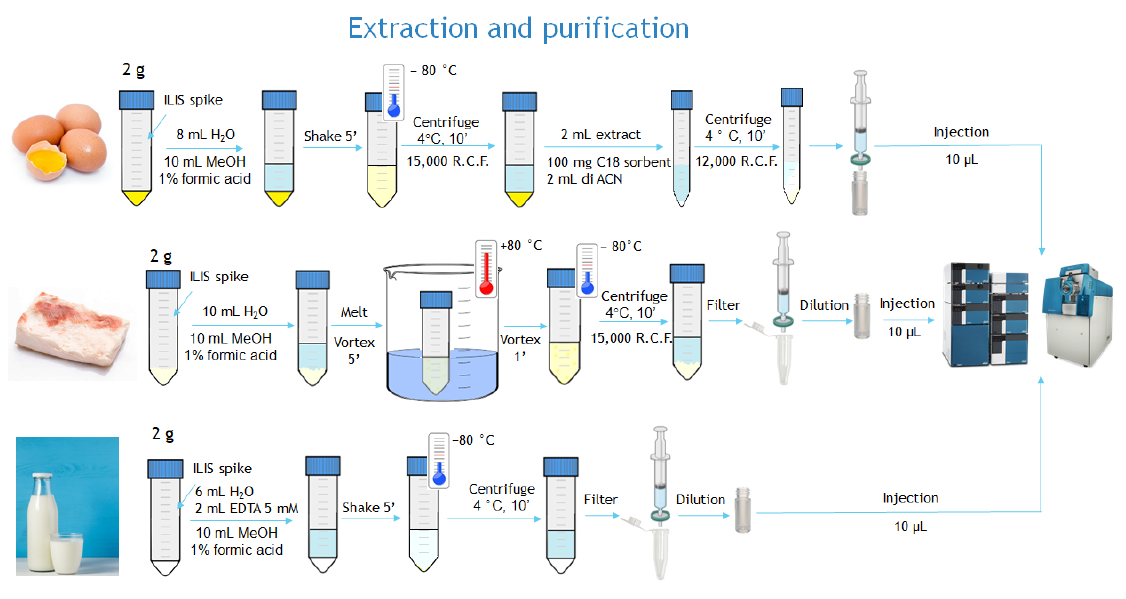
Figure 1. Schematic of sample preparation procedures.